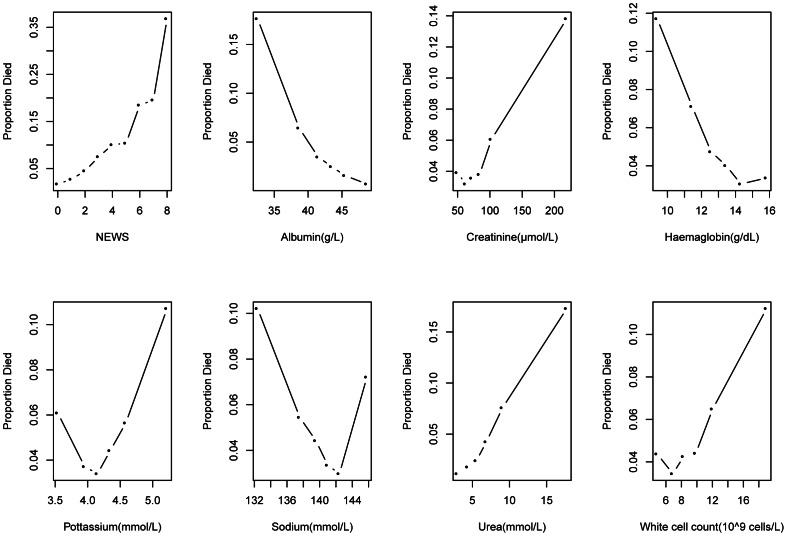
Scatter plots showing observed risk of death with NEWS and seven blood tests results.